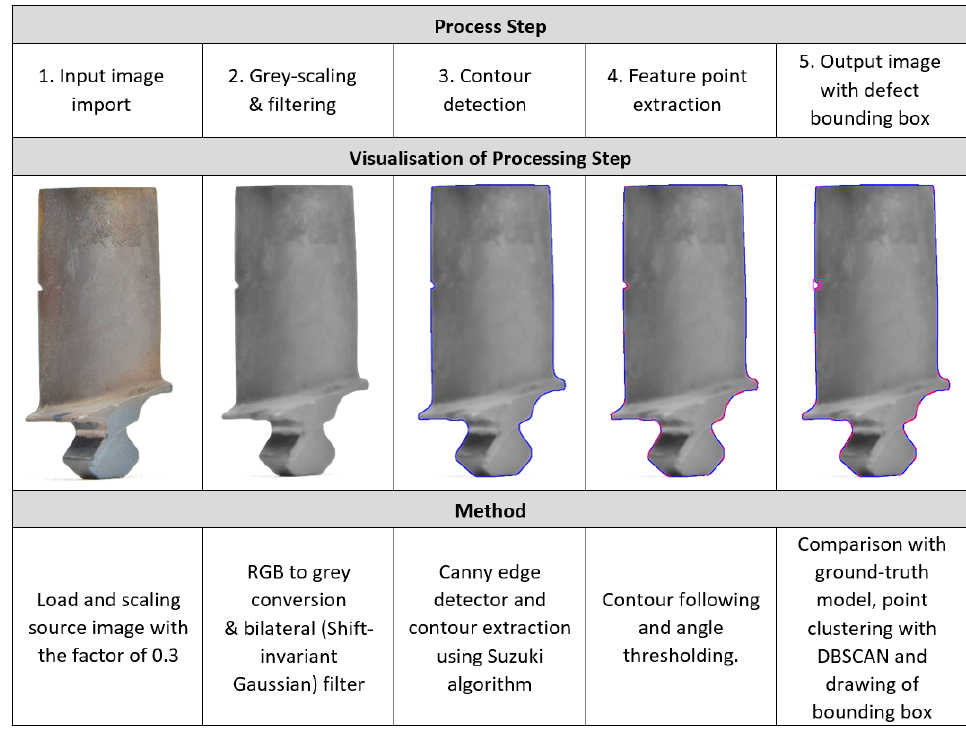
Figure 9. Current image processing procedure and defect detection output.